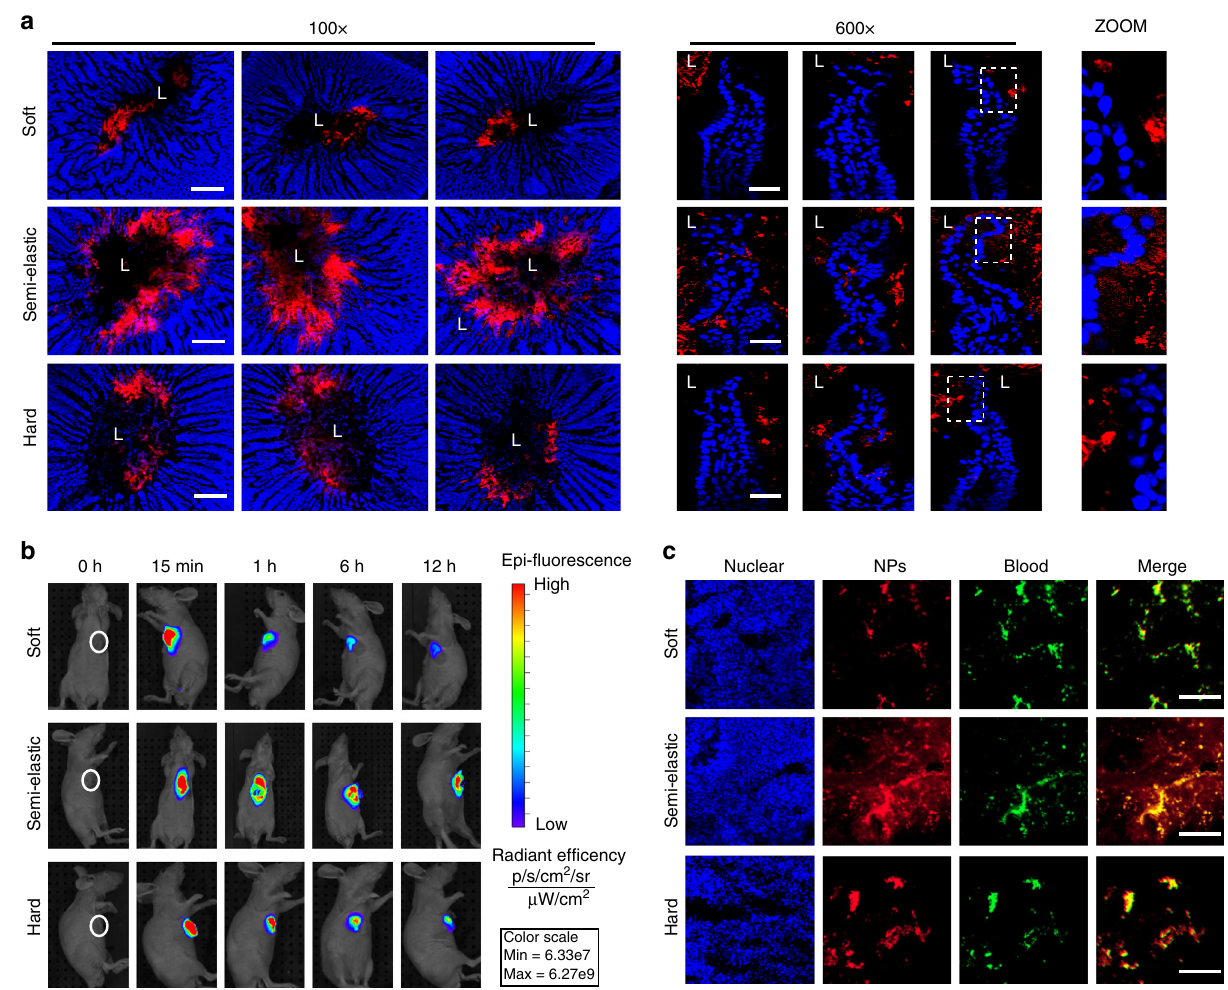
Fig. 4 NP entry into tissues covered with hydrogels in vivo. a Distribution of NPs in rat intestines. Intestinal ligated loops were incubated with DiI-labeled NPs for 1 h. Fluorescence micrographs were obtained from transverse cryo-sections of the intestines. “ L ” indicates the lumen of the intestine. Blue: nuclei of the intestinal villi. Red: NPs. b In vivo imaging of BxPC-3 and HPSC tumor-bearing mice taken at the indicated time points before and after peritumoral injection of IR783-labeled soft, semi-elastic, or hard NPs. c Distribution of DiI-labeled softer, semi-elastic, and harder NPs in tumor slices of BxPC-3 and HPSC tumor xenografts 6 h after peritumoral injection. The cell nuclei were counterstained with DAPI. The tumor vessels were labeled with anti-CD31 antibody. Scale bars: 50 μ m. Softer: Lip-F127 5% NPs; Semi: PLGA 70 -Lip-F127 5% NPs; Harder: PLGA 160 -Lip-F127 5% NPs. ( n = 3) curve (AUC) for the semi-elastic NPs was 8.1-fold, 4.0-fold, and